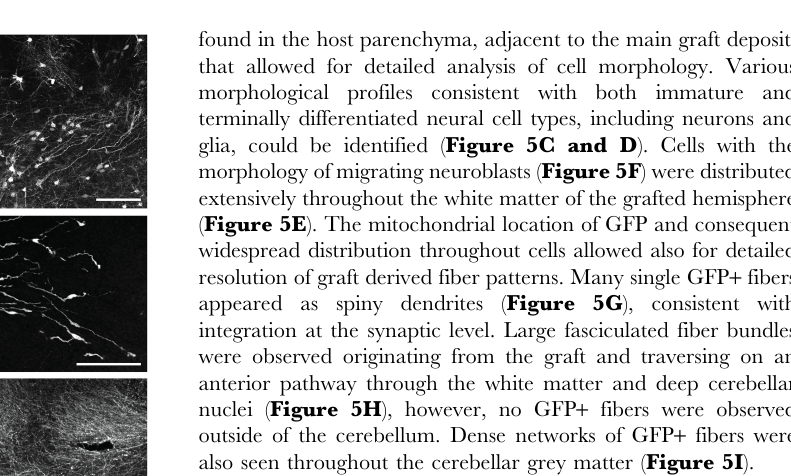
malate, pyruvate + malate) and CII-dependent (succinate) ATP